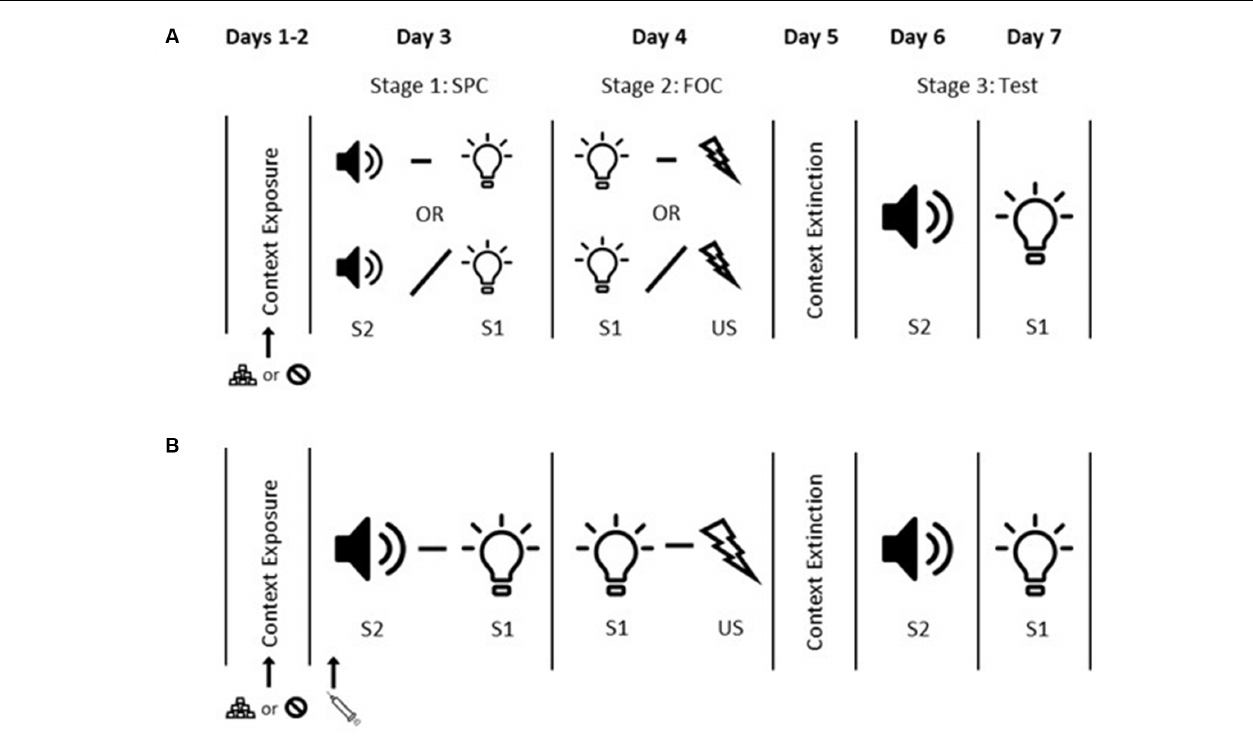
FIGURE 1 | Sensory preconditioning experimental timeline. Panel (A) shows the timeline for Experiment 1. Days 1 and 2 = context exposure. On Day 2 rats in the Appetitive condition received food pellet exposure during context exposure while rats in the Neutral condition did not. Day 3 = sensory preconditioning (SPC). Rats in Groups P-P and P-UP received paired S2 and S1 presentations (tone and light; counterbalanced). S2 and S1 were presented in an unpaired fashion for Group UP-P. Day 4 = first-order conditioning (FOC). Rats in Groups P-P and UP-P received paired S1-US (shock) presentations. S1 and US were presented in an unpaired fashion for Group P-UP. Day 5 = context extinction. Days 6 and 7 = tests of S2 alone and S1 alone. Panel (B) shows the timeline for Experiments 2–4. Days 1 and 2 = context exposure. On Day 2 all rats in Experiment 3 and rats in the Appetitive condition in Experiment 4 received food pellet exposure during context exposure. Rats in Experiment 2 and rats in the Neutral condition in Experiment 4 did not. Day 3 = SPC. All rats received paired S2-S1 presentations. Injections of dopamine antagonist or vehicle (according to the group) were administered prior to the SPC session. Day 4 = FOC. All rats received paired S1-US presentations. Day 5 = context extinction. Days 6 and 7 tests of S2 alone and S1